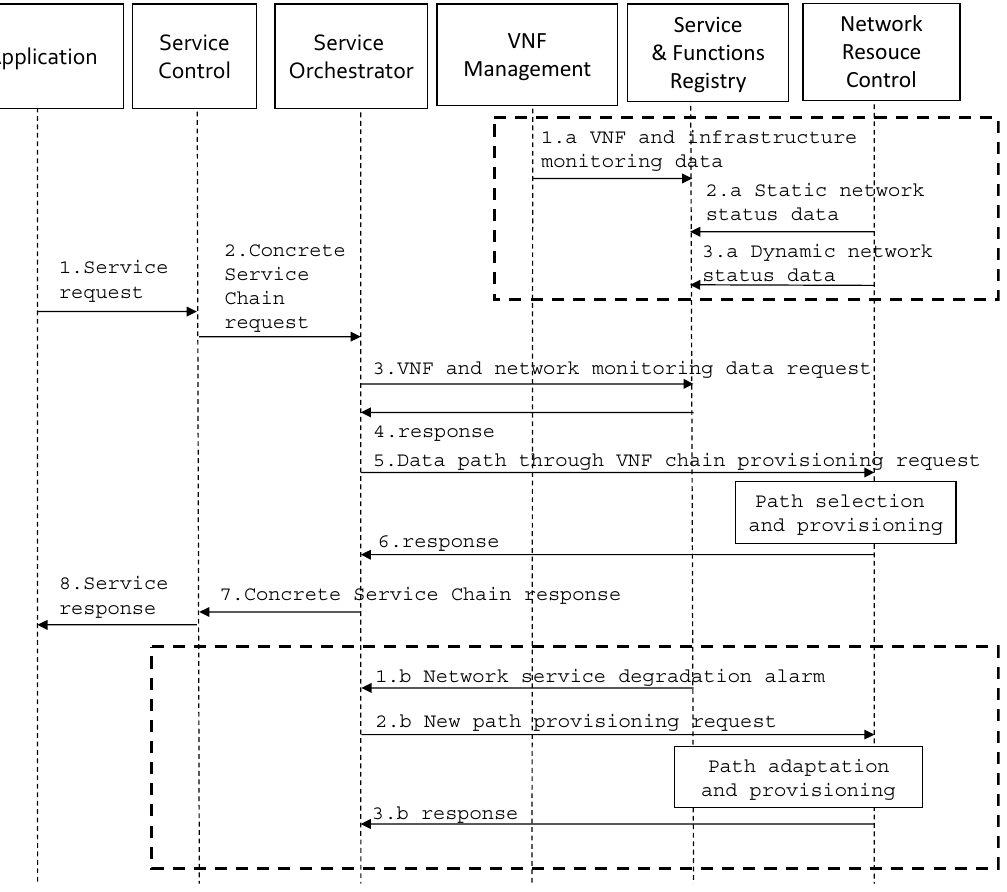
Figure 5. Orchestration workflows for adaptive service delivery.